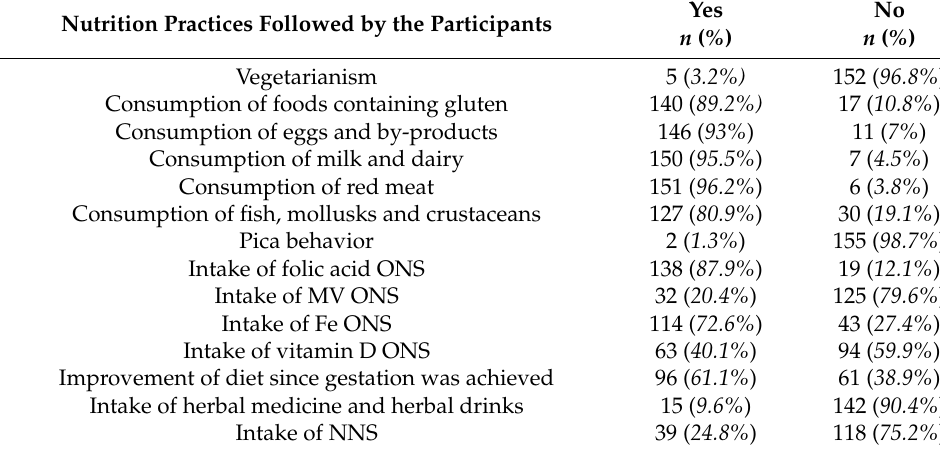
Table 2. Nutrition-related practices of pregnant women (N =